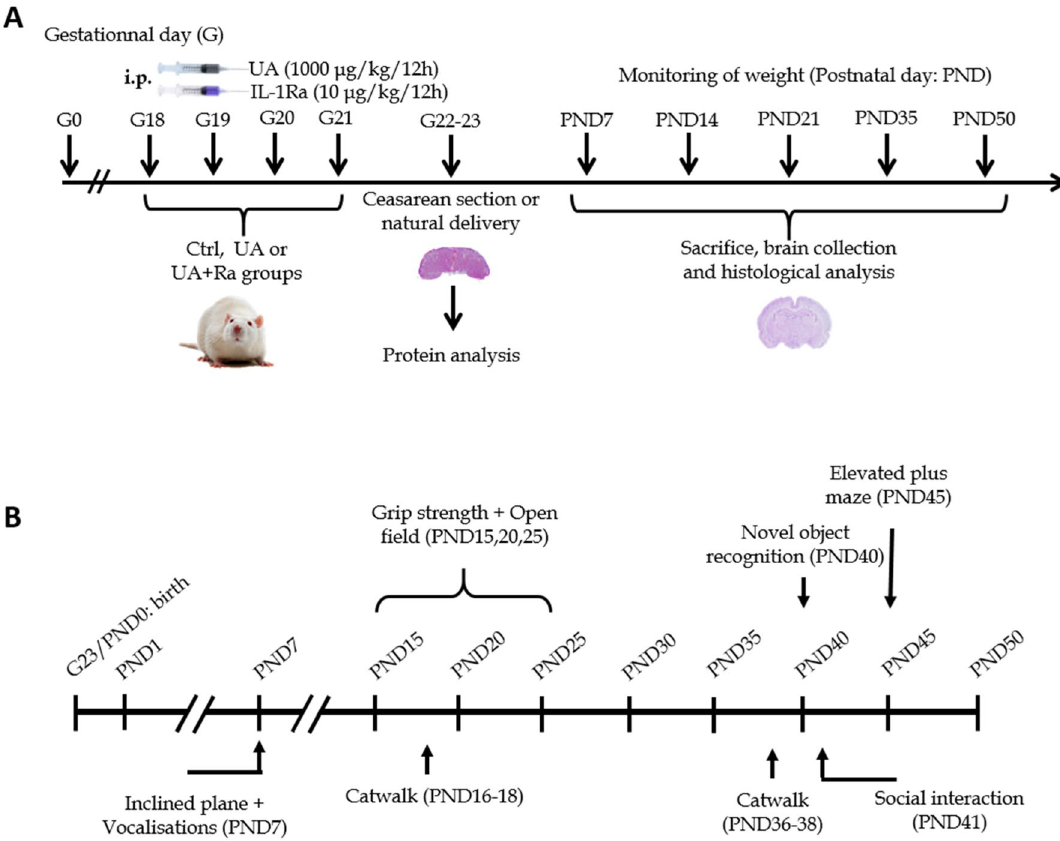
Figure 7. Experimental schedule of the model. Pregnant dams were injected i.p. every 12 h with uric acid from gestational day (G)18 to 21. C-section were performed at G22 for placental protein analysis. Natural delivery also occurred in parallel to evaluate the pups in the postnatal period from postnatal day (PND)1 through PND50 ( A ). Behavioural assessment schedule of the model. Eight different behavior tests were performed from postnatal day (PND) 1 to PND50 to evaluate motricity and cognitive functions ( B postnatal day (PND) 7 to assess the developmental equivalent of the infant human brain at term (36–40 weeks gestation); PND21 as the early adolescence developmental stage; PND35 as the early adult stage and PND50 for the adult brain. Both white and grey matters were evaluated at each timepoint (i.e. corpus callosum—CC; cingu- lum—CG; cortex; hippocampal-dentate gyrus—DG; hippocampal-cornus amonis—CA; and internal capsule— IC). The impact of sterile inflammation on the developing brain was evaluated using the following antibod- ies: ionized calcium binding adapter molecule 1 (Iba1; Wako Chemicals, VA, USA), glial fibrillary acid protein (GFAP; Chemicon, ON, Canada), myelin basic protein (MBP; Chemicon, ON, Canada), doublecortin (DCX; Abcam, MA, USA) and neuronal nuclei (NeuN; Millipore, MA, USA). Matched secondary HRP-conjugated antibodies were used, either anti-rabbit-HRP, or anti-mouse-HRP (BioRad, ON, Canada), and revealed using 3, 3-diaminobenzidine (DAB; VWR, ON, Canada). Sections were counterstained with hematoxylin. Images were obtained with a slide scanner (Axioscan; Zeiss, ON, Canada), analysis performed using ImageJ (NIH Image) and cell counting was done by a blinded individual. For these experiments, N = 8–16 litters (i.e. PBS = 11; IL-1Ra = 8; UA = 16; UA + Ra = 12) were used with 1 male and 1 female per litters included in each experimental group. Behavioral assessment. Several behavioral tests (e.g., inclined plane, ultrasound vocalisation, grip strength, open field, catwalk, social interaction, novel object recognition, elevated plus maze) were performed in the postnatal period (see Fig. 7B for the testing schedule). A period of 5 days of rest (i.e. no testing) was used between different tests. The animals were acclimatized into the room for at least 30 min before any behavioural assessment. 6 litters, with 1 male and 1 female pup each, were analysed in each group. Inclined plane was performed at PND7 to evaluate motor reflex as previously described 60 . Pups were placed head down on a grid plane at 45 degrees. The time for the animal to reach a full head up position was measured. Ultrasound vocalisations were analysed to assess pups’ communications as previously described 4 . At PND7, the pups were separated from their mother/littermate and placed in a box with ultrasound caption. The vocalisa- tions (frequencies: 30–65 kHz) were measured for 3 min using the Avisoft SASLab software (Avisoft Bioacoustics, Germany).